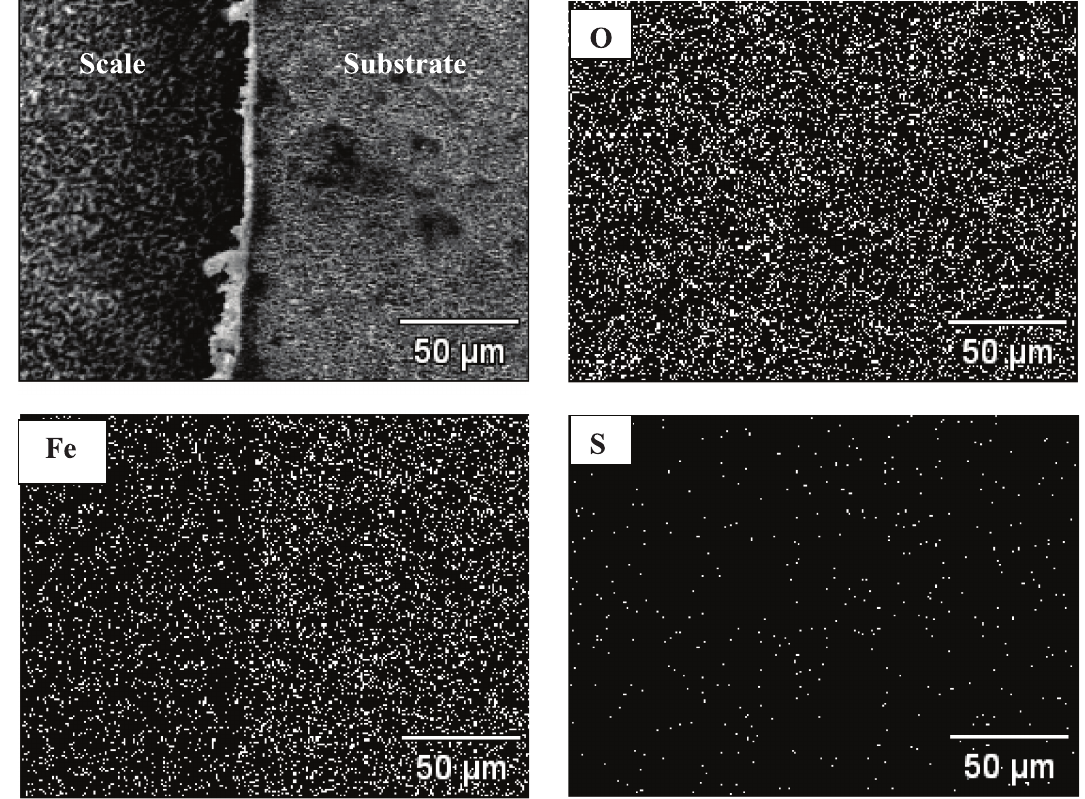
Fig. 8: X ray mapping analysis of oxygen (O), sulfur (S) and iron (Fe) of the scale and substrate of 70.7% deformed